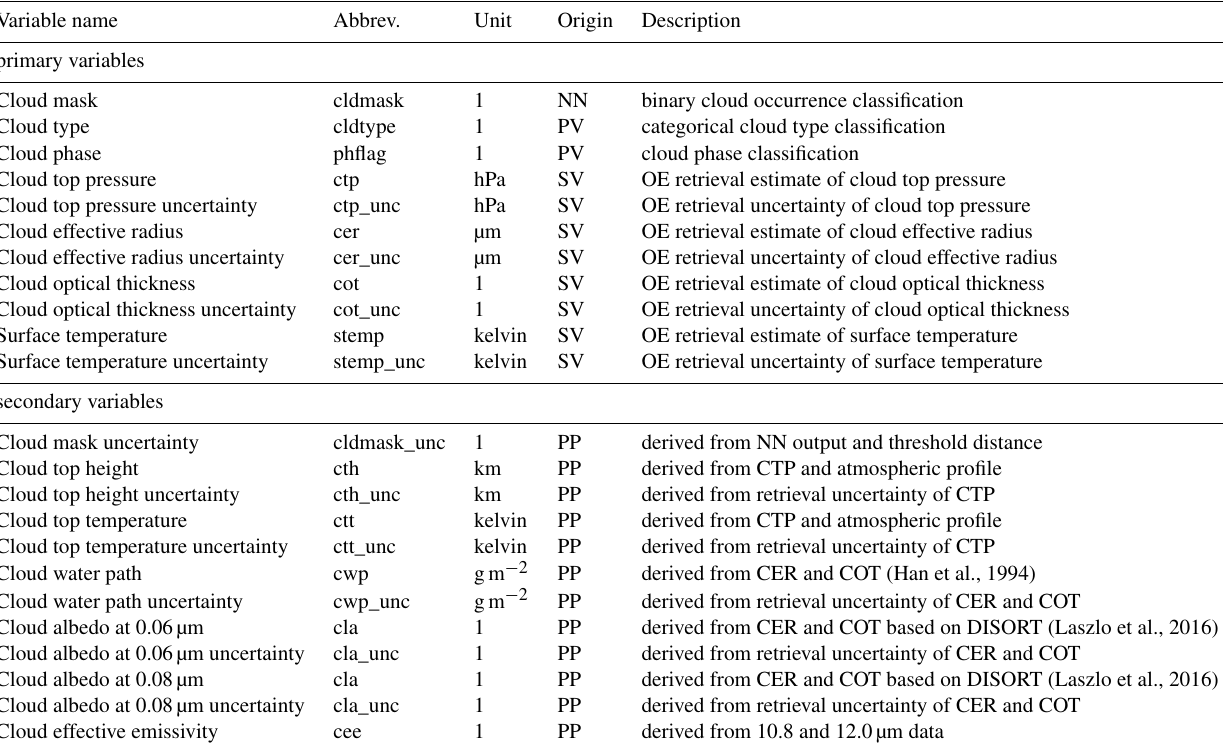
Table 5. CC4CL primary and secondary output. NN is neural network, SV is state vector, PP is post-processed, PV is Pavolonis et al. (2005) algorithm, and OE is optimal